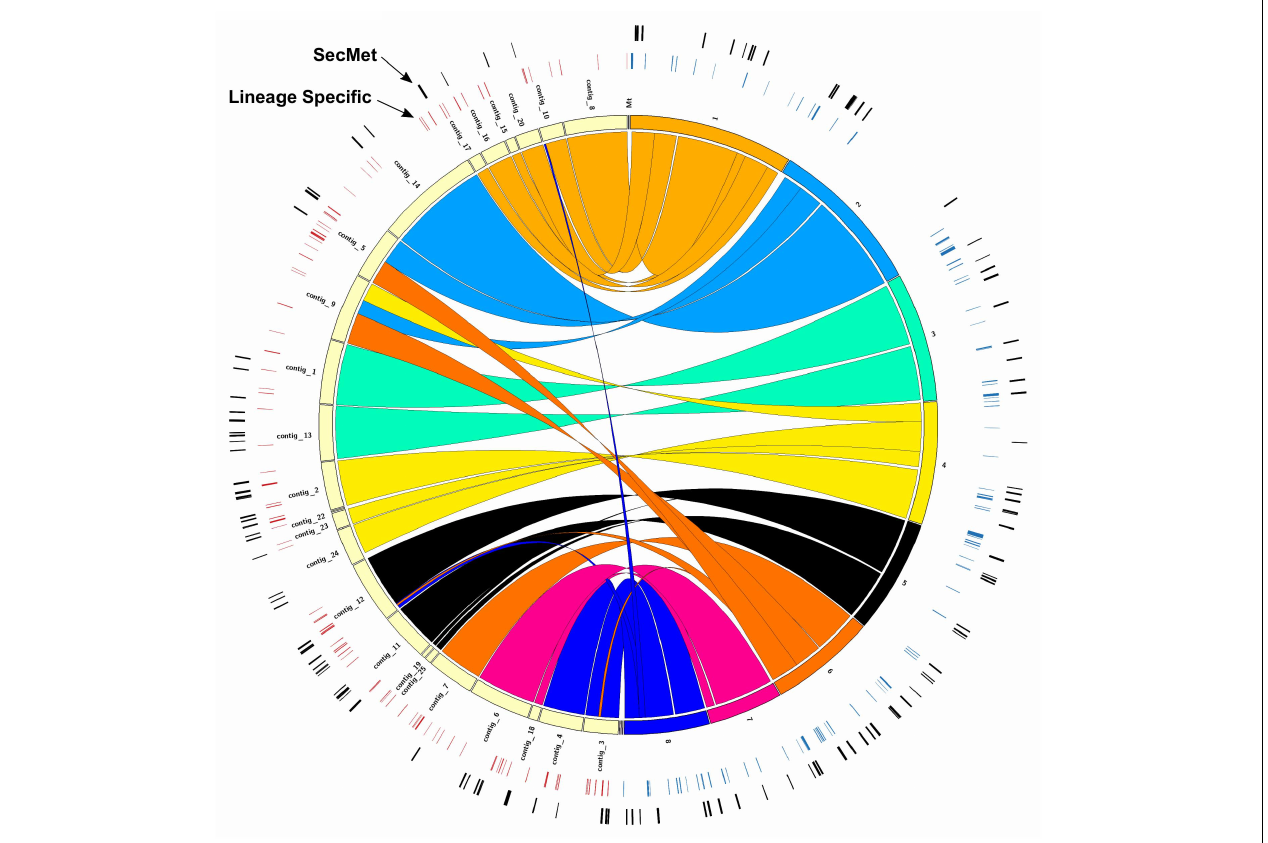
FIGURE 2 | Genome architecture between A. oryzae 14160 and RIB 40. Circos plot displaying similarity between the A. oryzae 14160 (left half of circle) and RIB 40 (right half of circle) genomes. The innermost ring represents A. oryzae 14160 scaffold ID or A. oryzae RIB 40 chromosome ID, and colored regions connecting the two represent regions with high sequence similarity ( ≥ 95%, length ≥ 10 Kb). The outer circles represent lineage specific genes and genes located within putative secondary metabolite encoding gene clusters (SecMet). The three small contigs to the left of A. oryzae RIB 40 chromosome 8 are AP007160, AP007177, and AP007156 (from left to